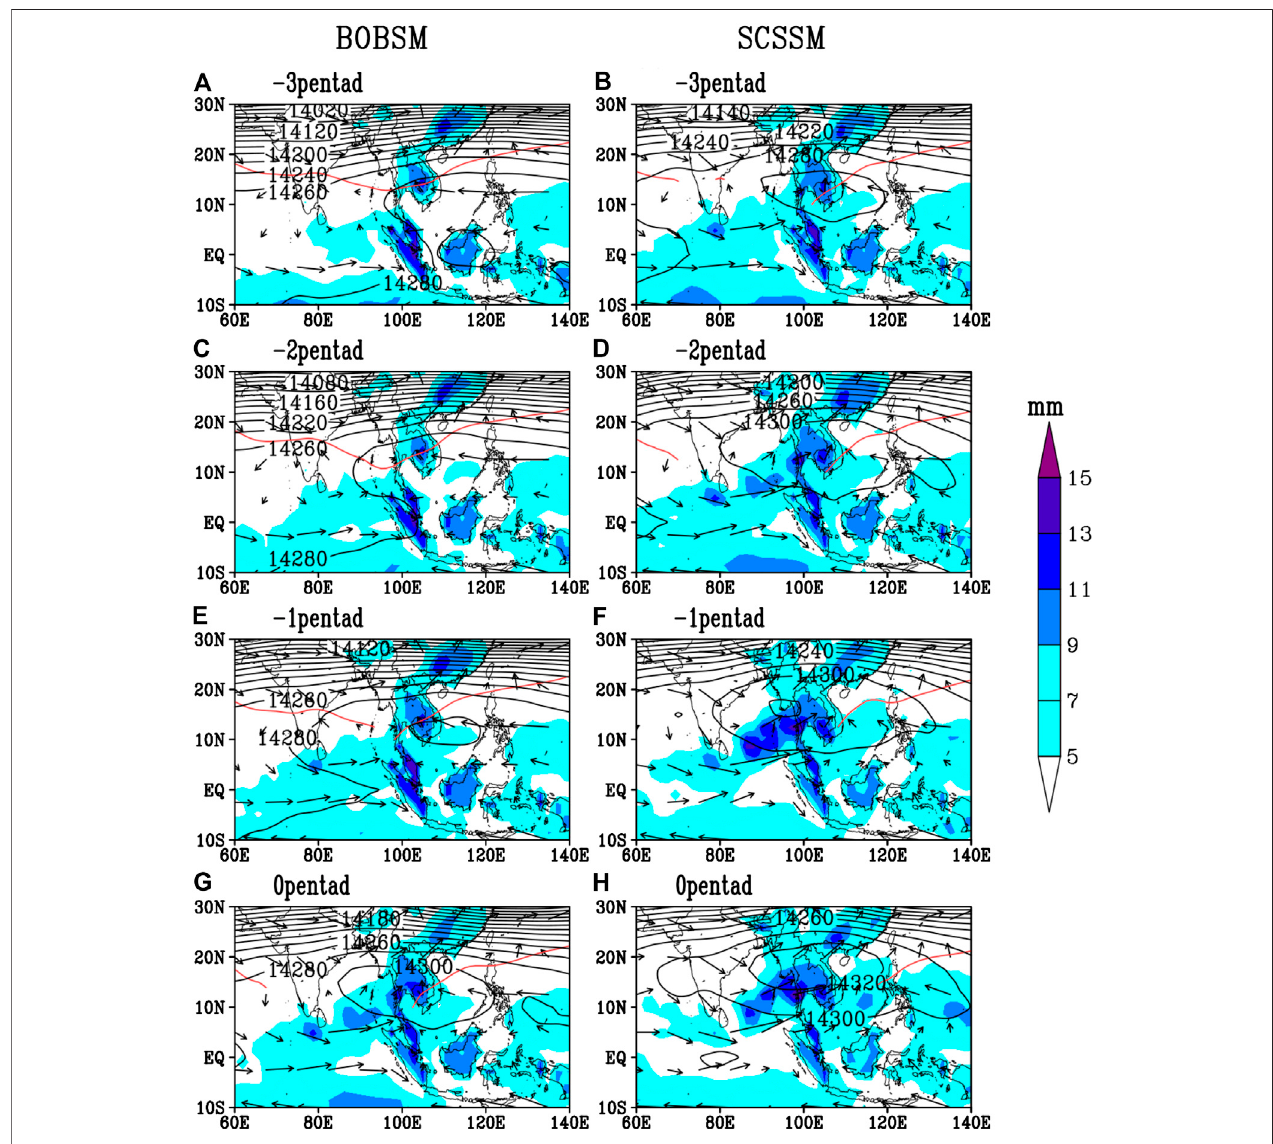
FIGURE 4 | Same as Figure 3 , but in the period of 1980 –